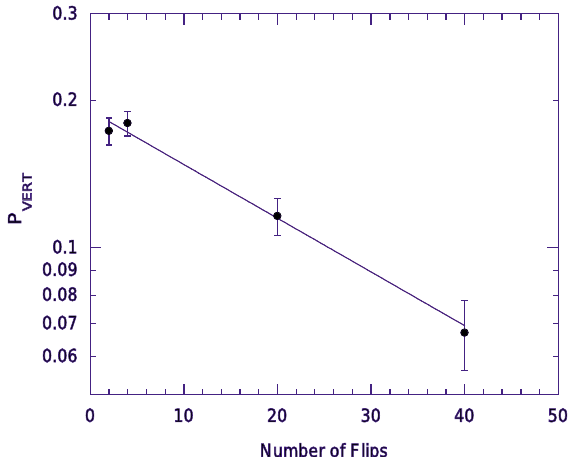
FIG. 5. (Color) The measured vertical proton polarization at 202.7 MeV is plotted against the number of spin flips. The rf dipole’s ramp time D t was 80 msec, its frequency range D f R B dl was 0.06 T mm. The curve is a fit to was 6 kHz, and its the data using Eq.